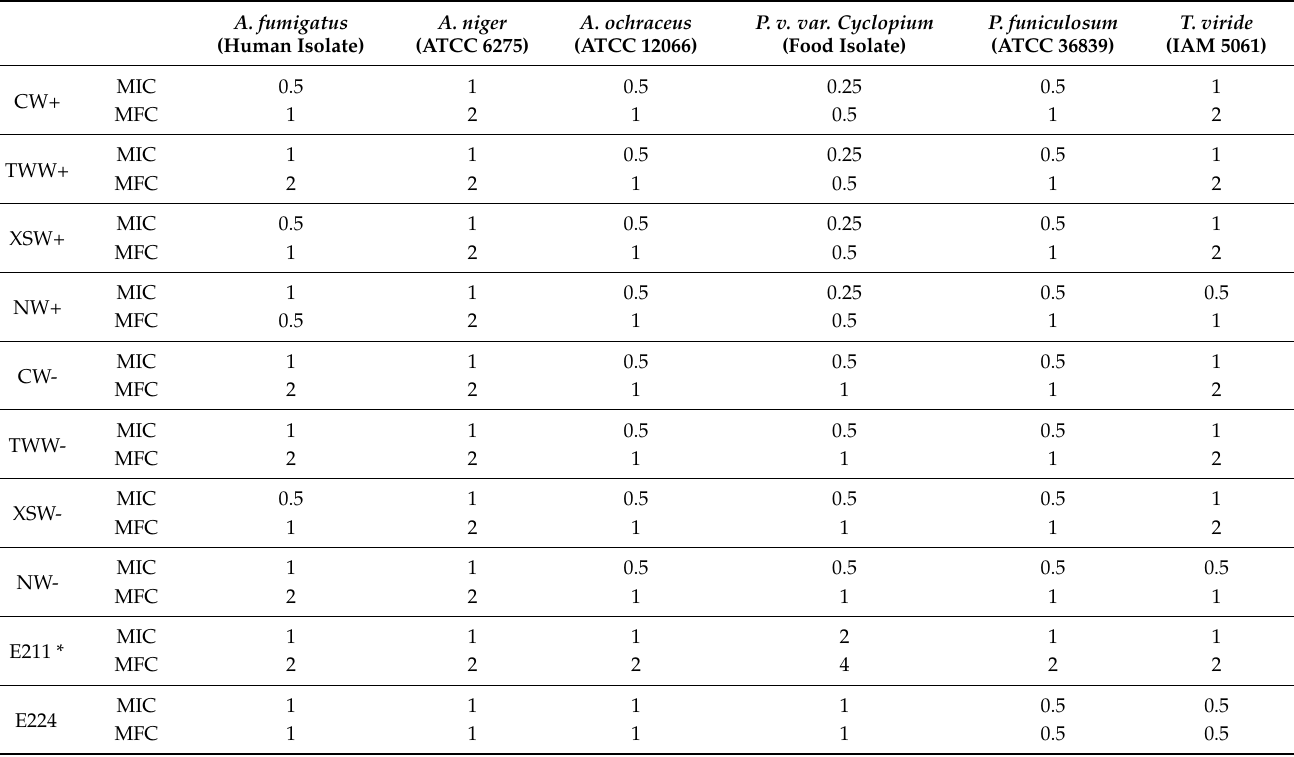
Table 6. Antifungal activity (MIC and minimal fungicidal concentration (MFC), mg/mL) of tomato fruit hydroethanolic extracts in relation to irrigation regime and biostimulant